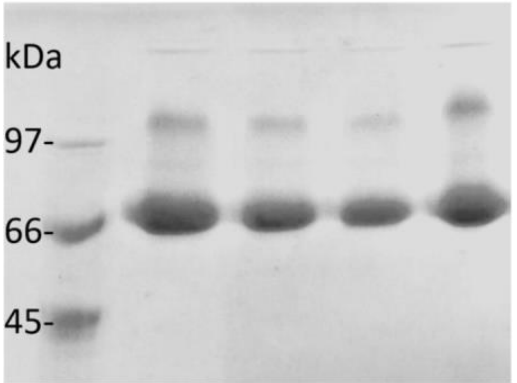
Figure 2. Electrophoresis gel (10% SDS-PAGE) of commercial amyloglucosidase (AMG, 300L).